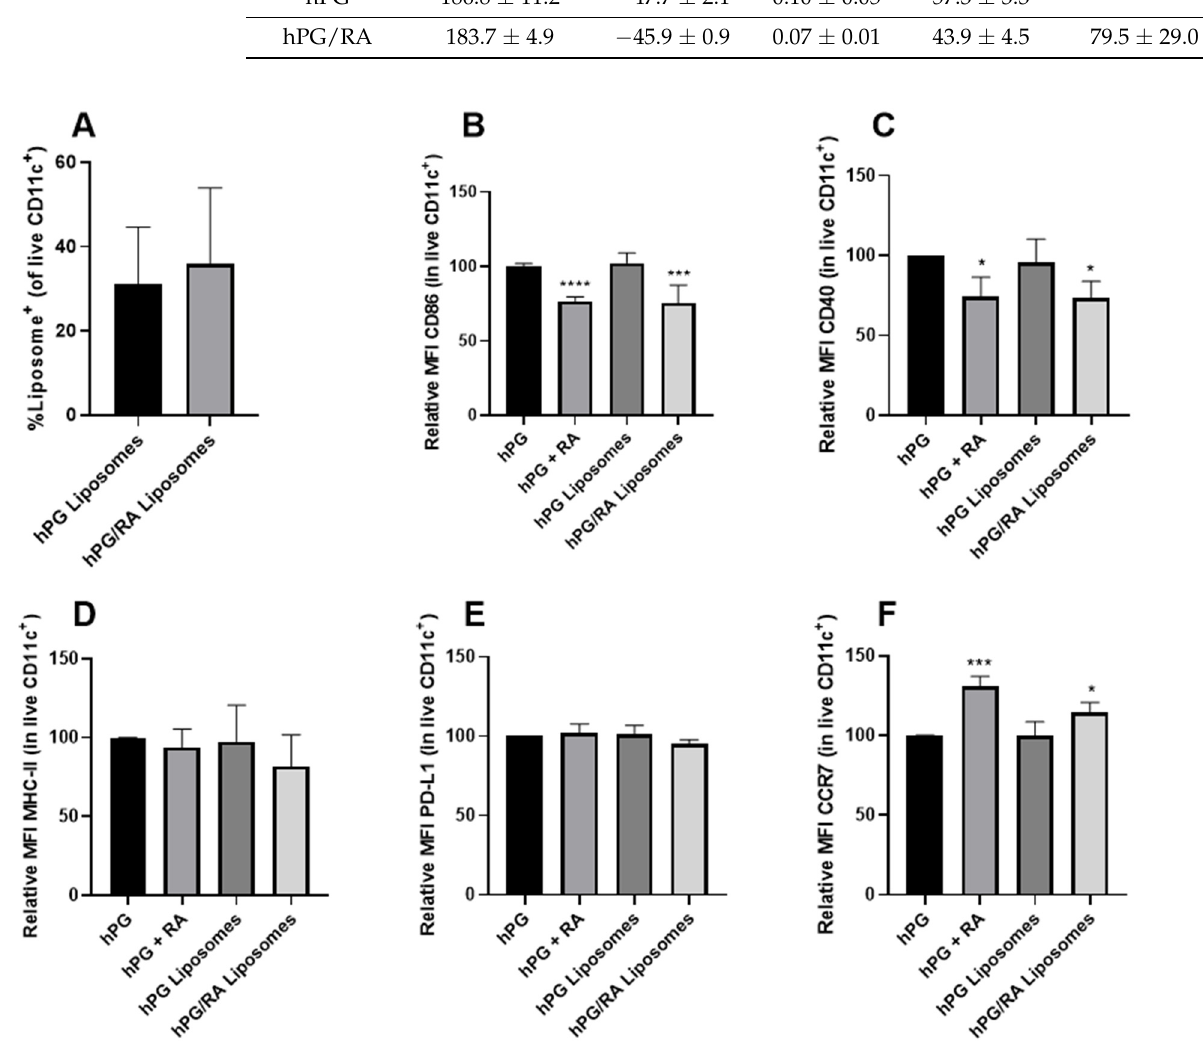
Figure 2. RA, free or encapsulated in liposomes, induces a tolDC phenotype in BMDCs. BMDCs were stimulated with LPS and cultured in the presence of hPG, hPG + RA, hPG liposomes or hPG/RA liposomes. The hPG and RA concentrations were constant in all groups. After 24 h of incubation, cells were washed thoroughly to remove unbound liposomes and analyzed via flow cytometry. ( A ) Percentage of live BMDCs positive for the fluorescent label in the liposomes. ( B – F ) Relative MFIs (compared to hPG control) of several DC markers. Combined data of four independent experiments. Means + SD, **** p < 0.0001, *** p < 0.001, * p < 0.05 compared to free hPG determined by mixed-effects analysis and Dunnett’s multiple comparisons test.